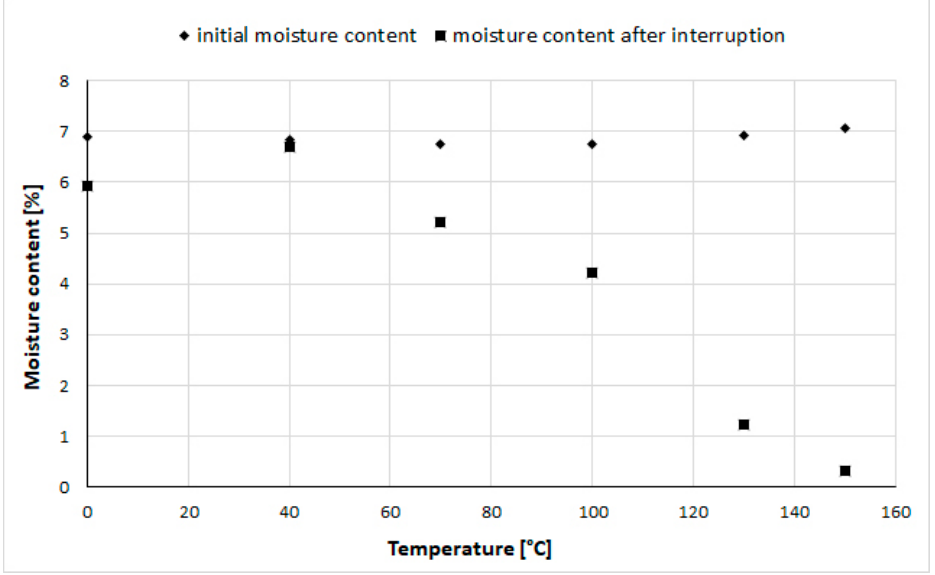
Figure 5. Moisture content of CE samples in interrupted DMA temperature scan experiment, prior to experiment (diamonds) and at the moment of interruption (squares).